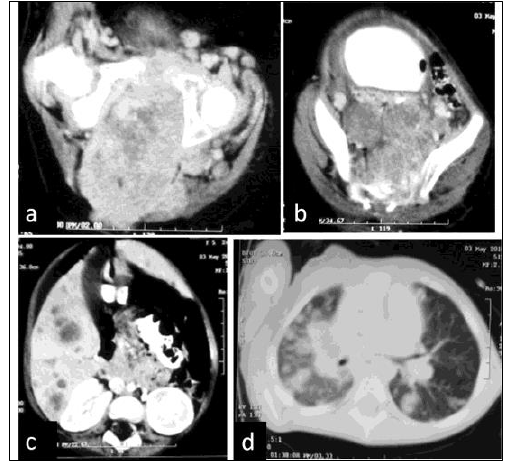
Figure 5: Differentiation between two different subtypes of pre- dominantly cystic SCT by MRI. (a and b) Sagittal T2 and T1 WI of a one-day-old female with purely cystic subtype of SCT (C1); note the homogenous hyperintense signal in T2, hypointense in T1, and thin capsule. (c and d) Sagittal T2 and T1 WI of a 12- month-old female with complex multi-compartmental cyst (C2) displaying variable signal intensities and presence of fatty com- ponents .